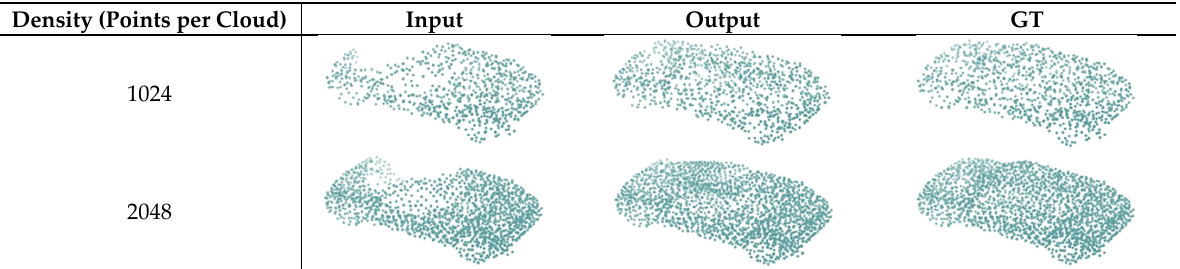
Figure 6. Some point cloud shapes with poor completion.